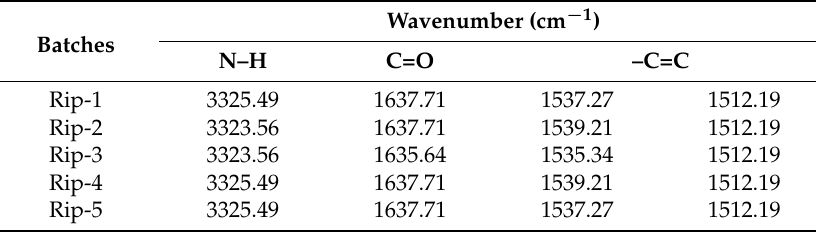
Figure 5. FTIR spectra of riparin batches. Table 2. FTIR spectra recorded in KBr pellet of RIP batches 1–5.